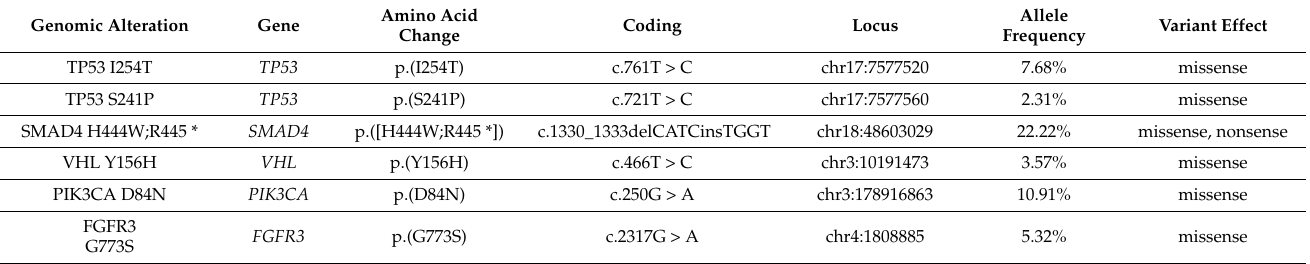
Table 2. Genomic alterations that were detected in the tumor tissue. Allele frequency below 50% was considered a somatic mutation [6]. No synonymous variants were included in the table even if the allele frequency was below 50%, but are included in the Supplementary Materials. * Automatic reporting from Ion Reporter and Oncomine Reporter of mutations for the most advanced phase (IV, III, II/III, II, I/II, I) is shown and multiple clinical trials may be